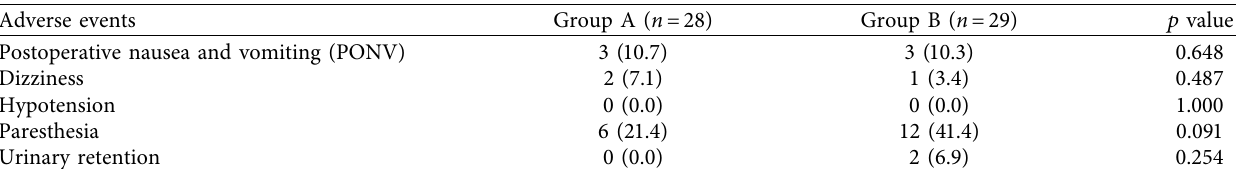
Table 6: Incidences of adverse